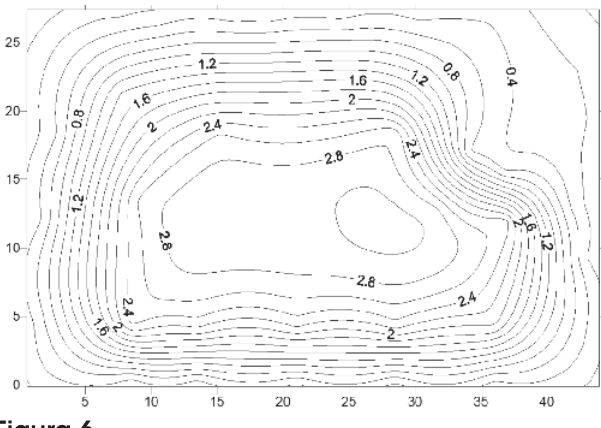
Curvas iso-recalques do projeto, em